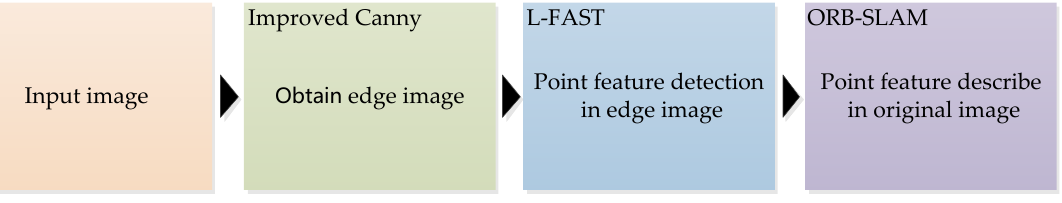
Figure 2. The flowchart of L-FAST.